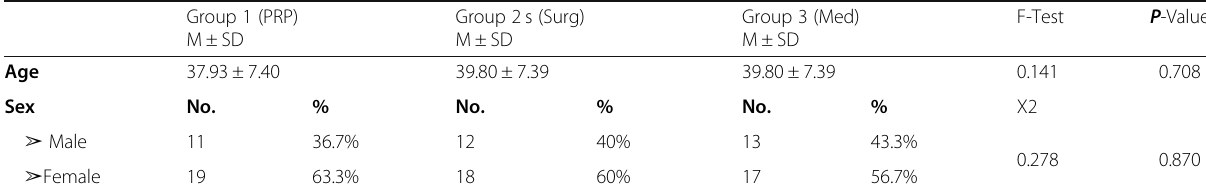
Table 1 Demographic data among patients of the three